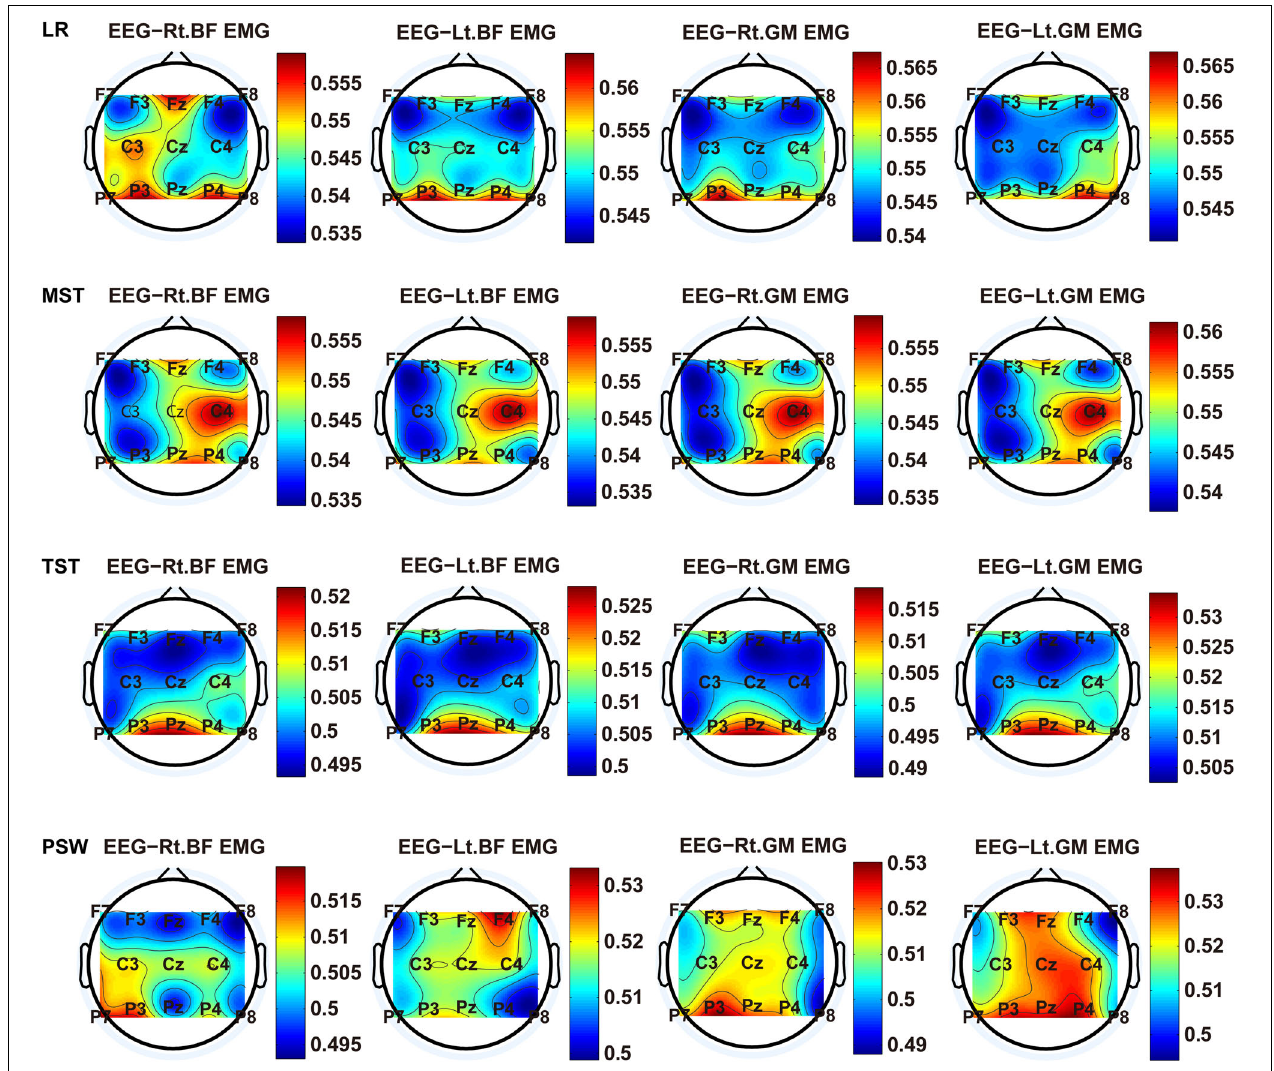
FIGURE 7 | TFCMI topography between EEG (beta band) and sEMG (BF and GM) of the stance phase (LR, MST, TST, and PSW).